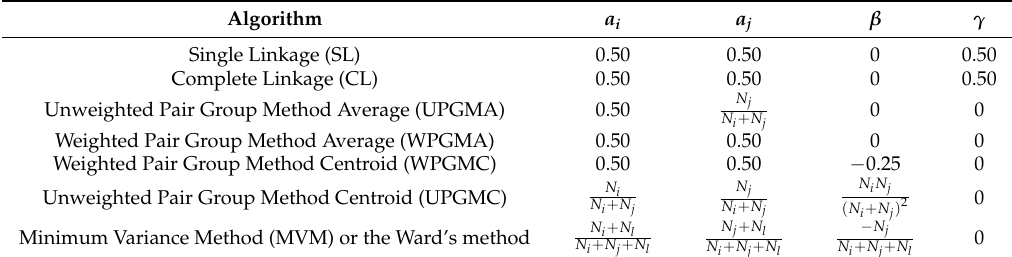
Table 1. Coefficients of the hierarchical agglomerative